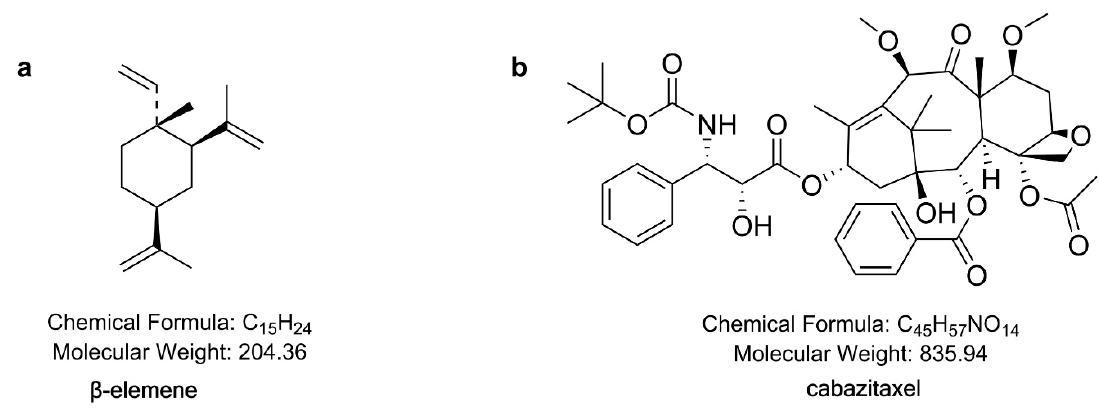
Figure 1. The chemical structure of β -elemene and cabazitaxel.